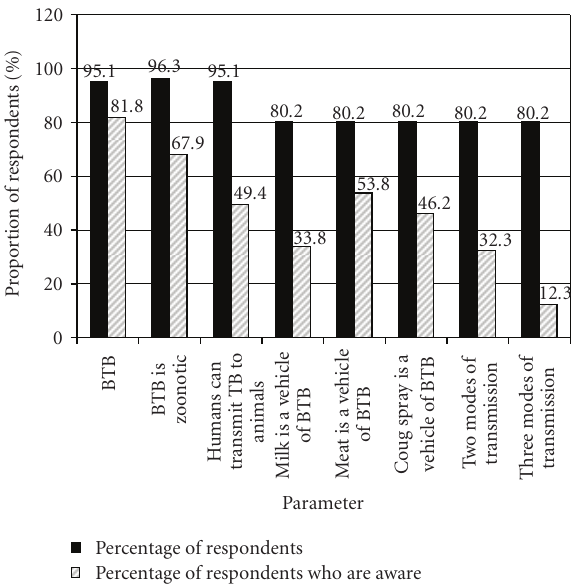
Figure 2: Awareness of cattle handlers to threats of bovine tuberculosis (BTB) and its modes of